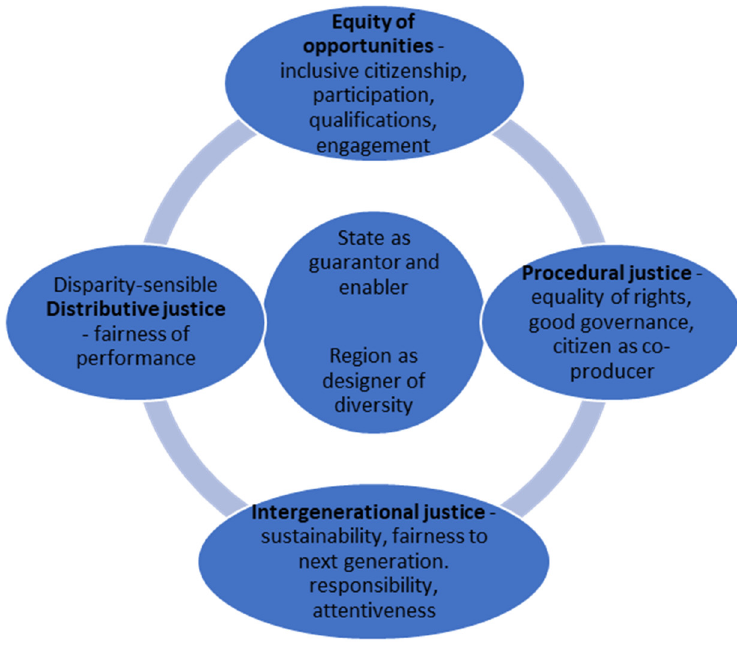
Figure 1. Magel’s and Miosga’s model of territorial justice. Source: [18].